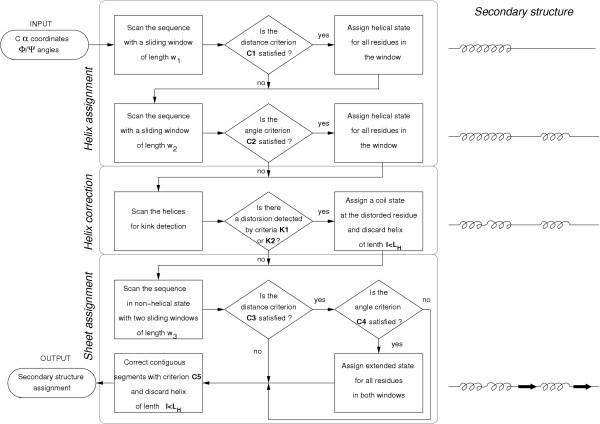
Flow-chart of the kaksi heuristic for secondary structure assignment. Minimum length for helices is set to LH = 5. The criteria C1, C2, C3, C4, C5, K1 and K2 are detailed in the text.